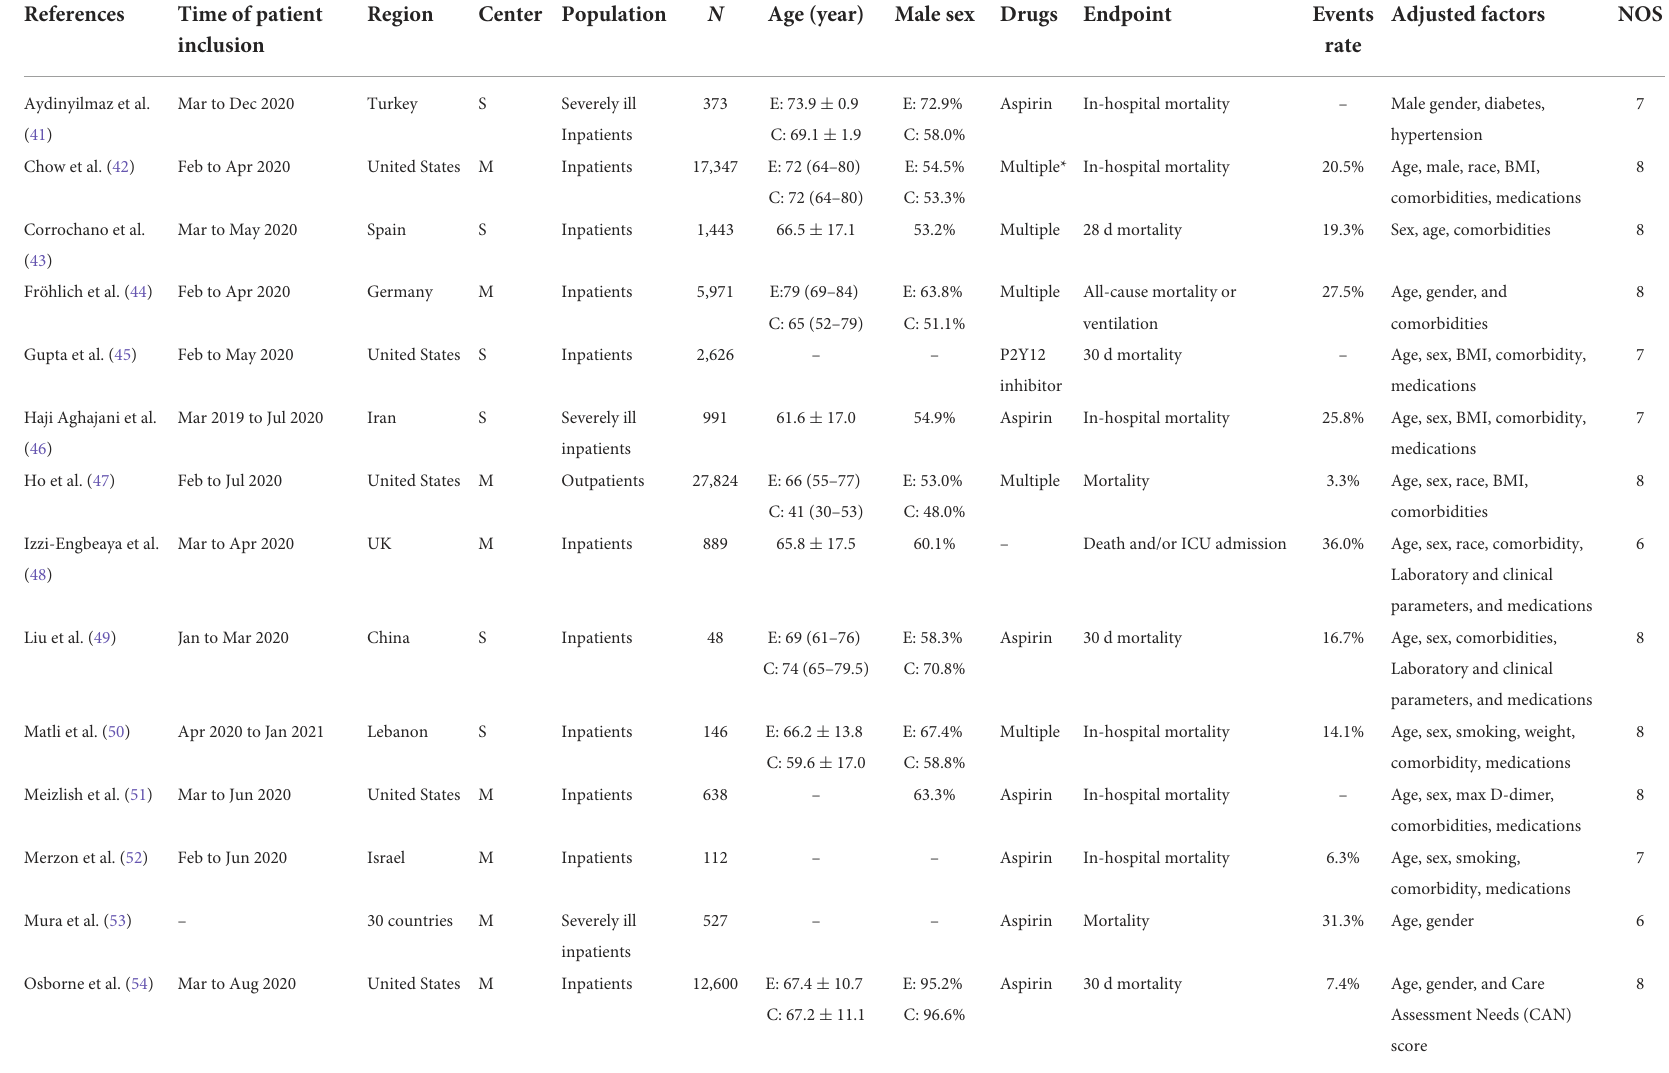
TABLE 1 Details of observational studies included in this meta-analysis of the association between antiplatelet treatment and